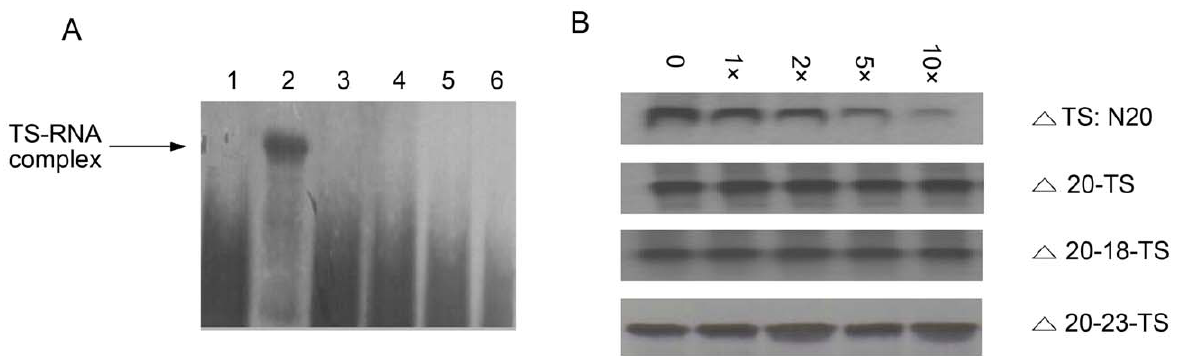
Figure 5. Interaction of TS:N20 with zebrafish TS protein in vitro. A , Gel mobility shift analysis of TS:N20 interaction with TS protein. A 20-nt TS RNA, which included nt 13–32, was synthesized and radio-labeled with 32 P. 32 P-labeled-TS:N20 RNA was incubated in the absence (lane 1) or presence of 100 ng (lane 2) of pure recombinant zebrafish TS protein. A 32 P-labeled 17-nt TS encompassing nt 13–32 with a deletion of the GCU sequence, D 20-TS RNA, was incubated in the presence of 100 ng of zebrafish TS protein (lane 3). Lanes 4 and 5 represent the other two mutation variants, D 20–18-TS RNA and D 20–23-TS RNA, respectively, incubated with 100 ng of pure TS protein. TS:N25 RNA was incubated with 100 ng TS protein in the presence of 100 ng unlabeled full-length TS mRNA (lane 6). Samples were resolved on a non-denaturing 5% acrylamide gel and visualized by autoradiography. The specific RNA–protein complex is indicated (arrow). B , Competition analysis using TS oligomers with TS protein. 32 P-labeled full-length TS RNA (10 5 cpm) was incubated with 200 ng of pure zebrafish recombinant TS protein in the presence of 0–10-fold molar excess competitor, TS:N20 RNA (panel 1), D 20-TS RNA (panel 2), D 20–18-TS RNA (panel 3) and D 20–23-TS RNA (panel 4). The RNA–protein complex was resolved on a non-denaturing 5% acrylamide gel and visualized by autoradiography.